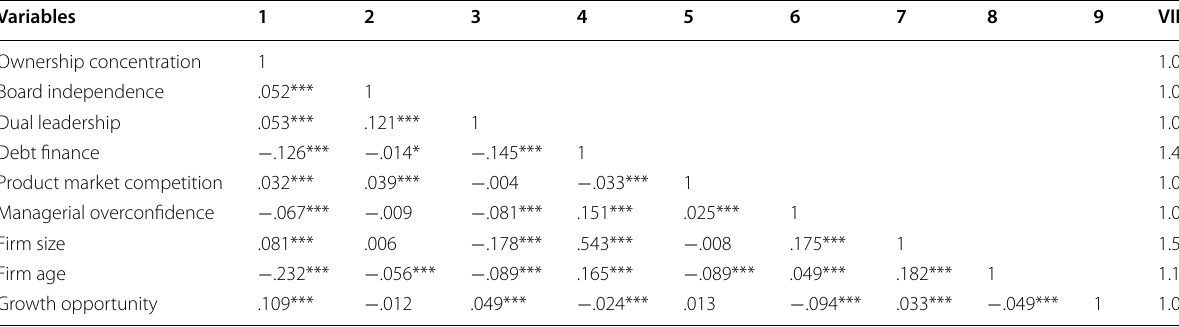
Table 2 Correlation matrix and VIF of variables Variables